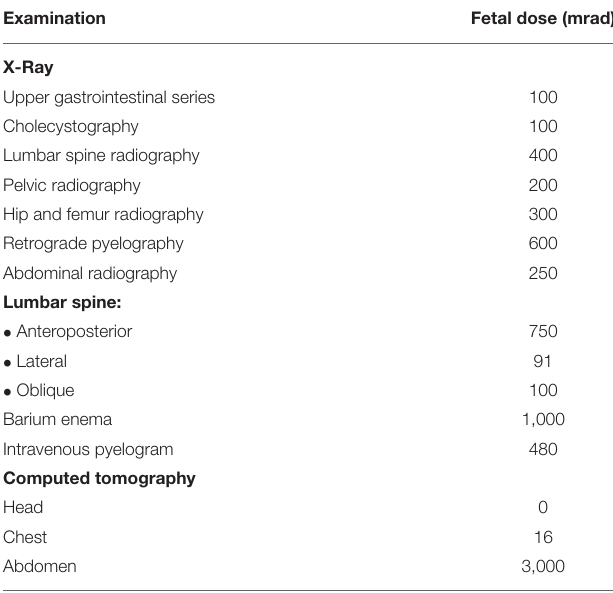
TABLE 1 | Estimated fetal radiation adsorbed doses during some common radiodiagnostic procedures (adapted from Ratnapalan et al.) (35).